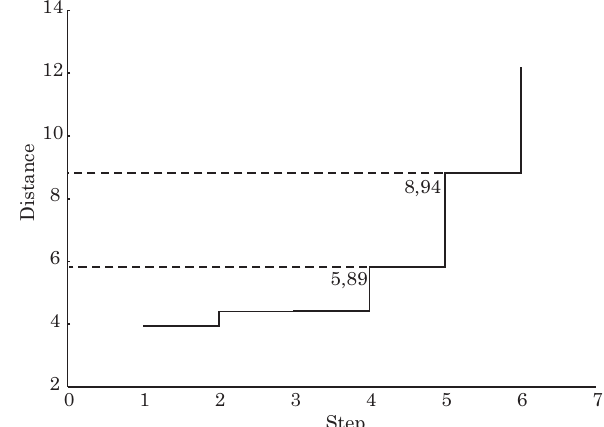
Figure 1. Representation of the significant variation of the Euclidean distance between the variables considered to be allowing the separation of